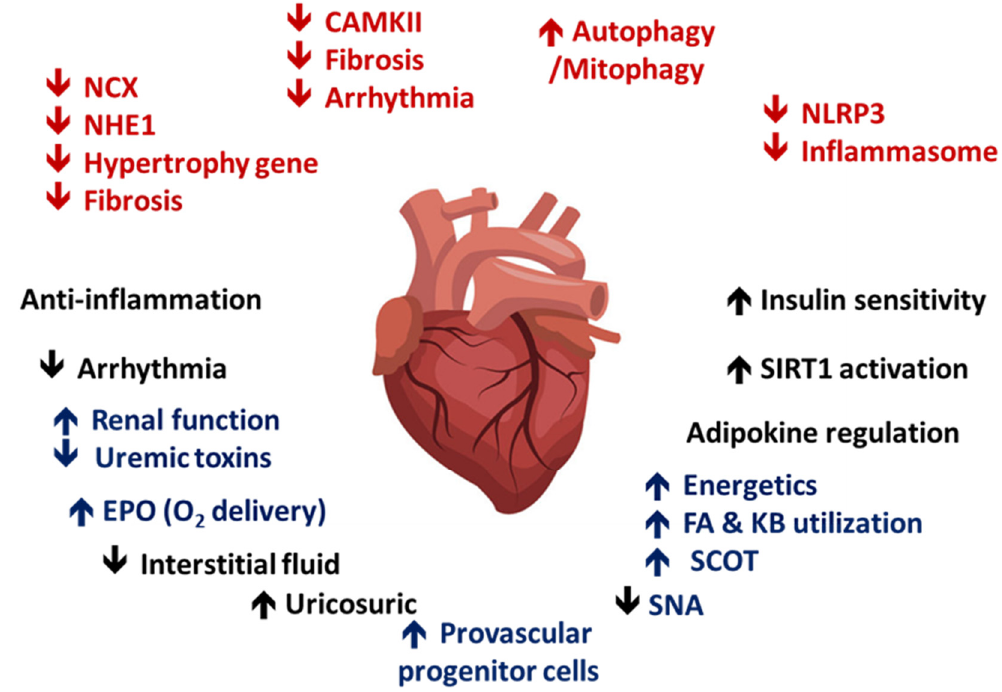
Figure 4. Direct (red) myocardial and indirect / systemic (blue) e ff ects of SGLT2i: the cardioprotective e ff ect of SGLT2i. SGLT2i could alleviate cardiac fibrosis by modulating autophagy and inflammation. SGLT2i also indirectly alleviates cardiac injury by modulating metabolism and the sympathetic